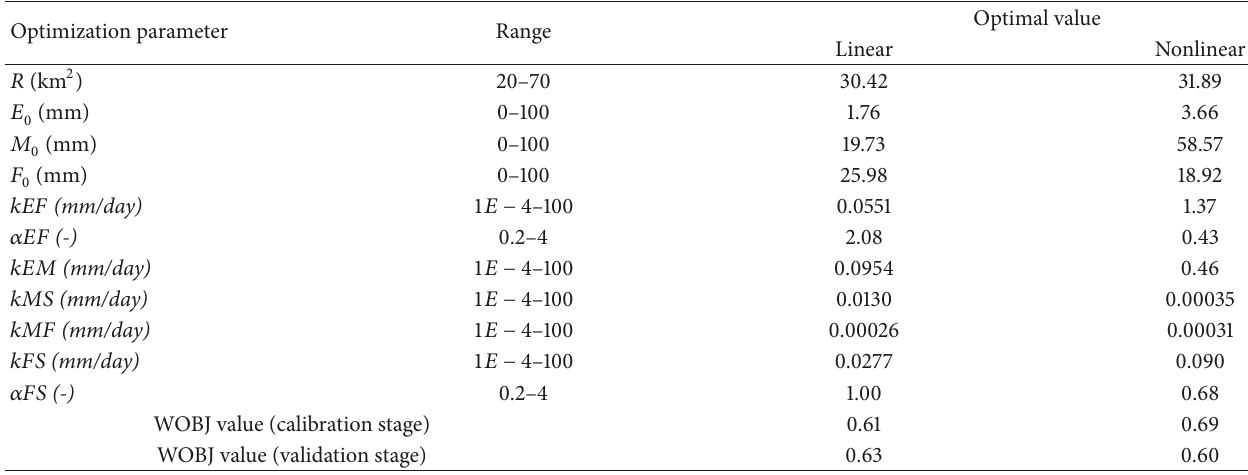
Table 2: Ranges of parameter values carried out by the optimization procedure based on the input hydrograph obtained using (1) (linear and nonlinear) and the optimal values of the parameters used for calculating hydrographs with the KarstMod